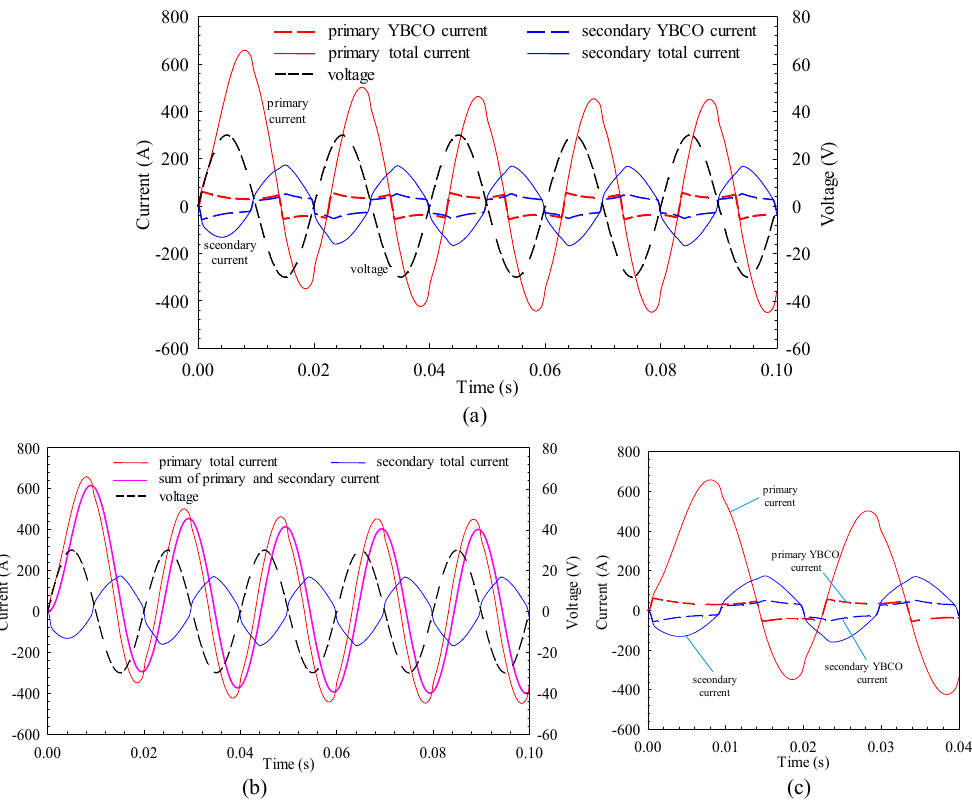
Figure 7. Simulation results of voltage and current curves at voltage magnitude of 30 V: ( a ) Overall curves, ( b ) net current that generates magnetic flux, ( c ) details of curves at first two cycles.